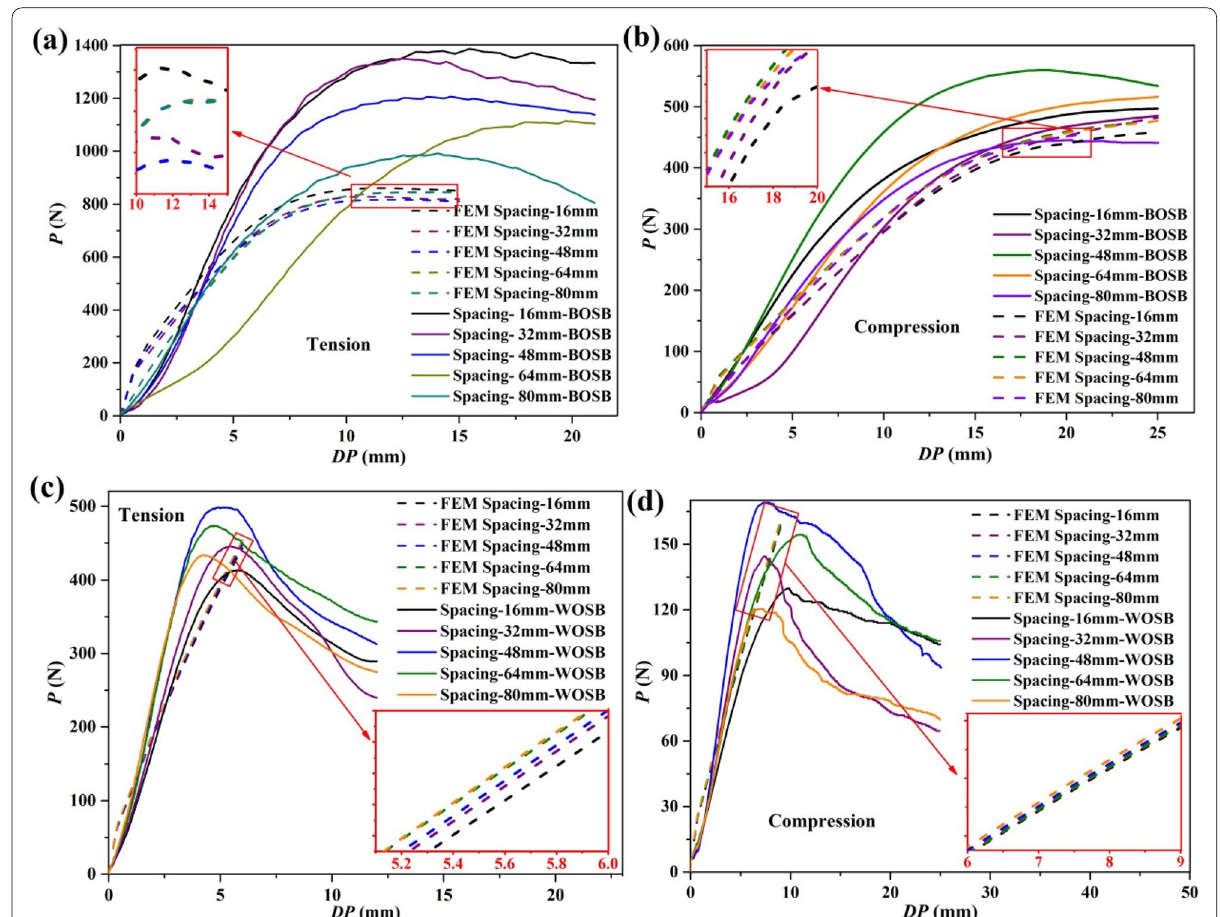
Fig. 5 The displacement–force curve of joints: a , b was tension and compression test curves of BOSB joint, c , d was tension and compression curves of WOSB